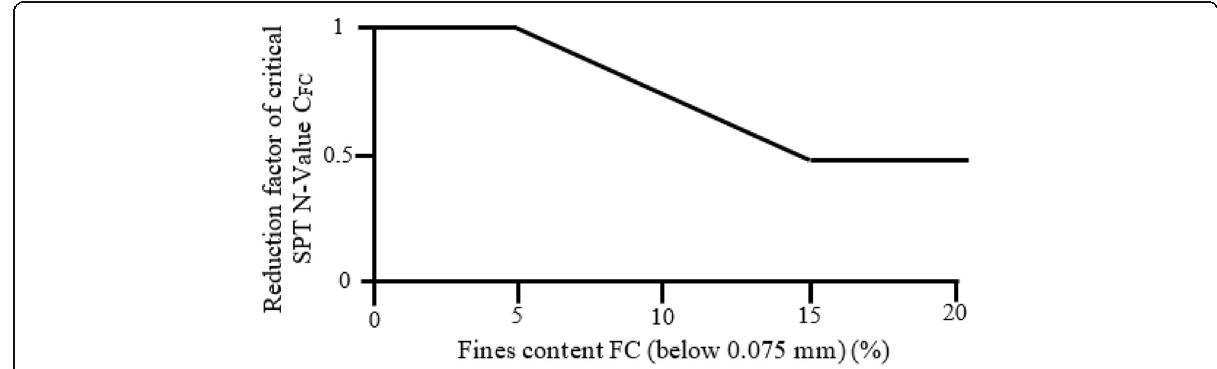
Fig. 3 Compensation factor of equivalent N -value corresponding to fine contents